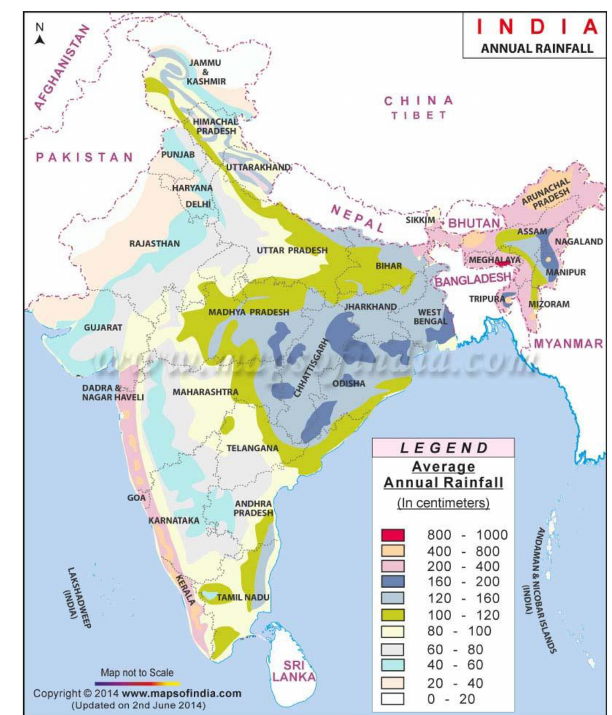
Figure 1. Different states of India and the annual rainfall (cm) over